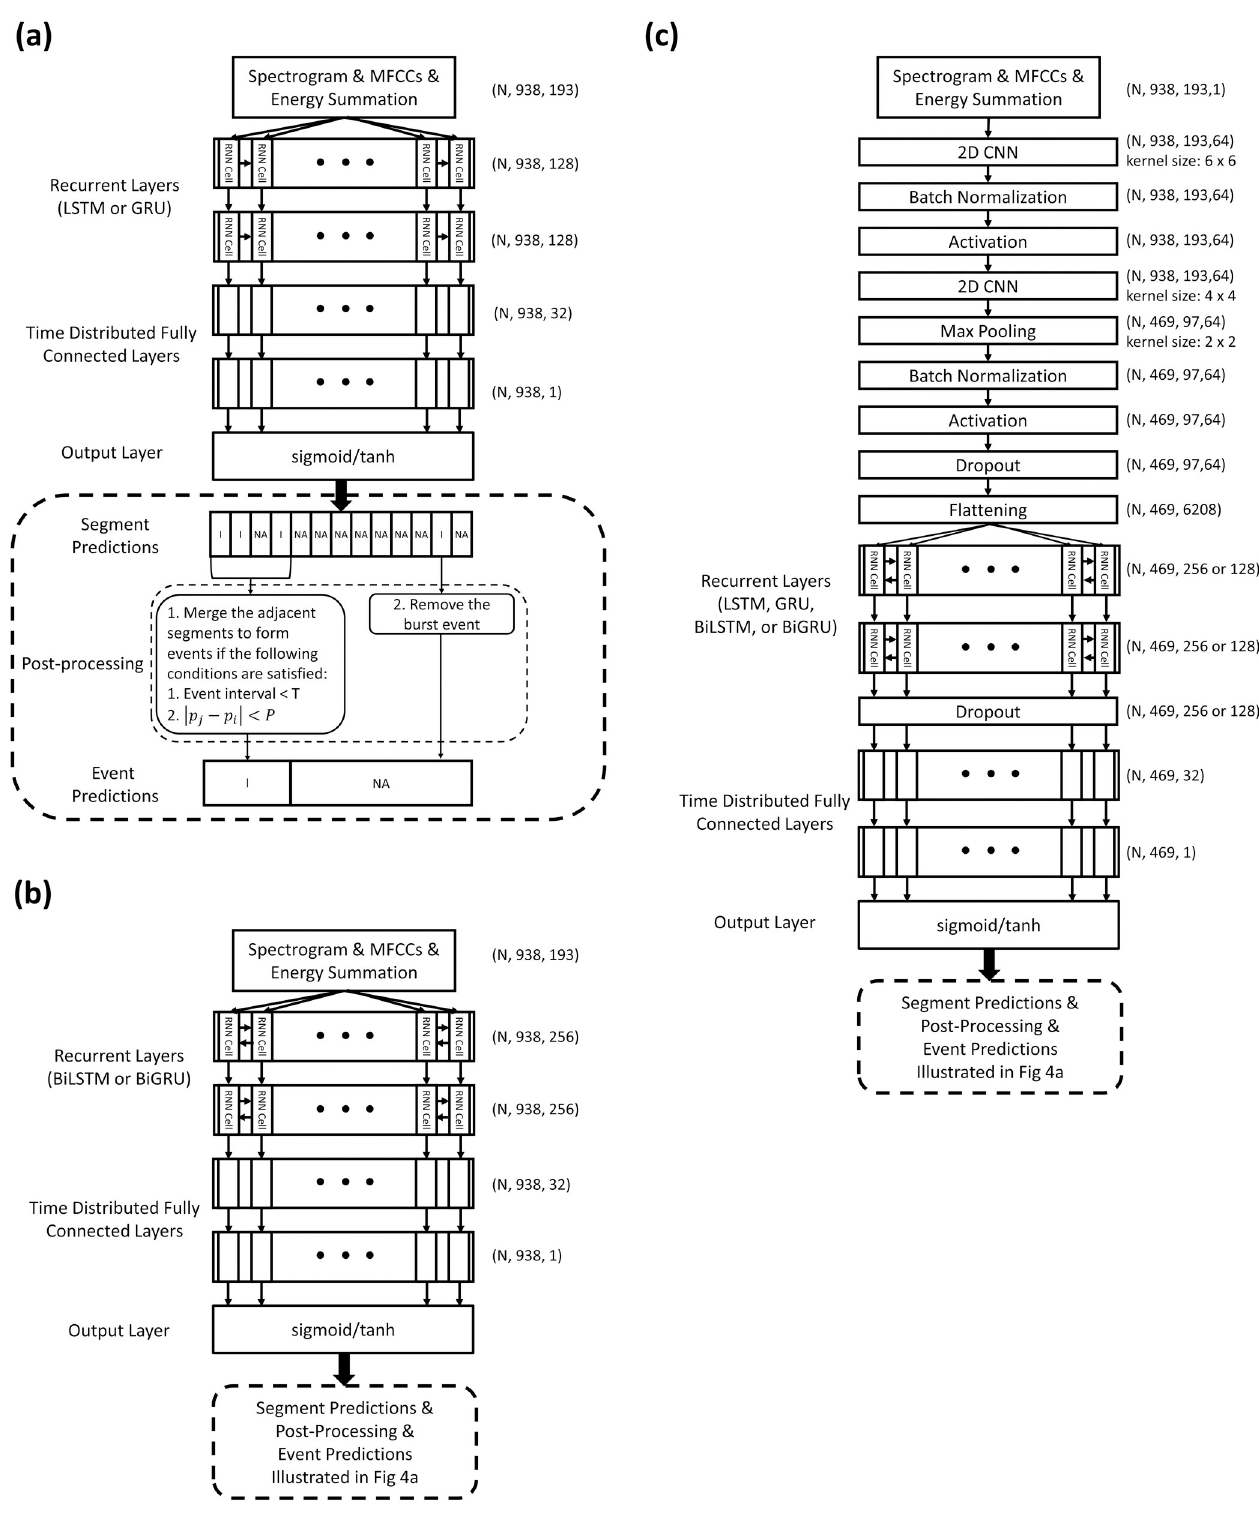
Fig 4. Model architectures and postprocessing for inhalation, exhalation, CAS, and DAS segment and event detection. (a) LSTM and GRU models; (b) BiLSTM and BiGRU models; and (c) CNN-LSTM, CNN-GRU, CNN-BiLSTM, and CNN-BiGRU models.